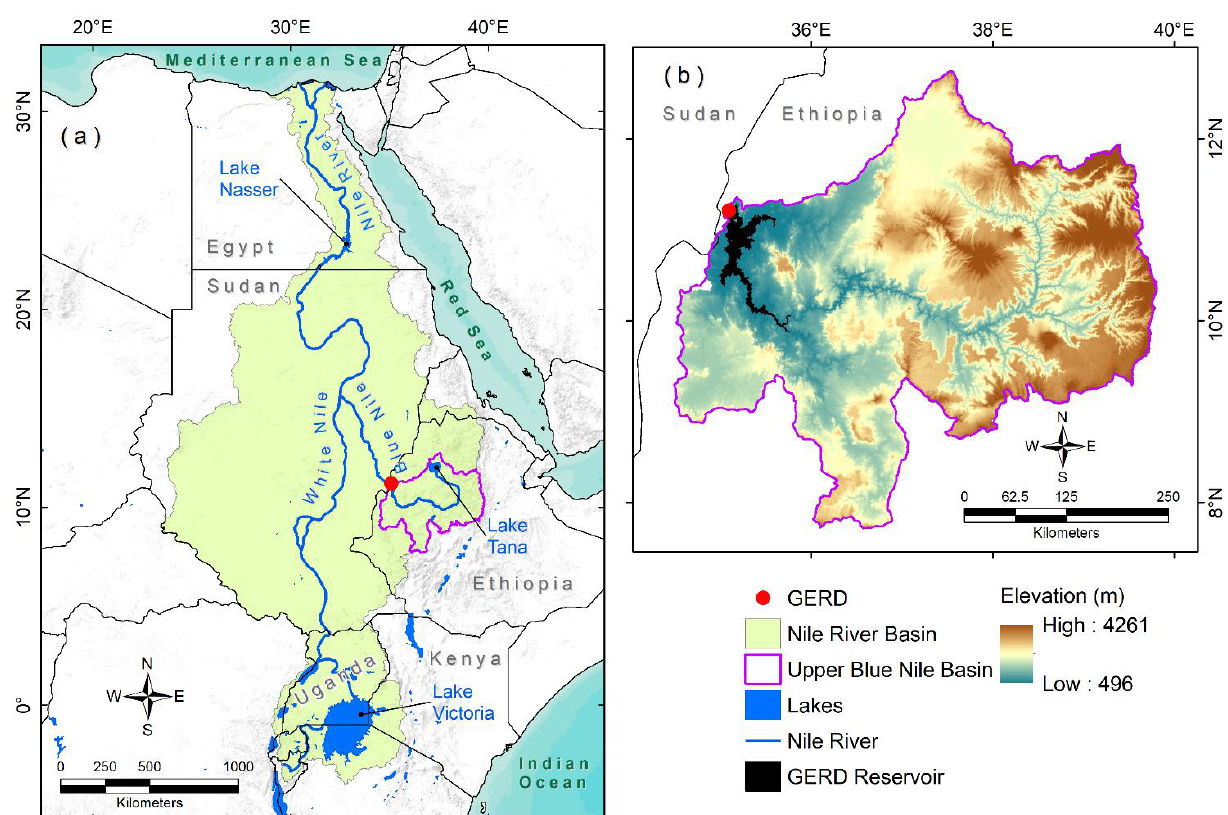
Figure 1. ( a ) Spatial distribution of the Nile River Basin (NRB) in Northeast Africa, encompassing the Blue Nile originating from Ethiopia, the White Nile originating from Uganda, and the Nile River flowing through Egypt and draining into the Mediterranean Sea. The locations of the Grand Ethiopian Renaissance Dam (GERD), Lake Nassar, Lake Tana, Lake Victoria, and Upper Blue Nile sub-basin are also shown. ( b ) Elevation of the Upper Blue Nile sub-basin. The locations of the GERD and the GERD reservoir are also shown.